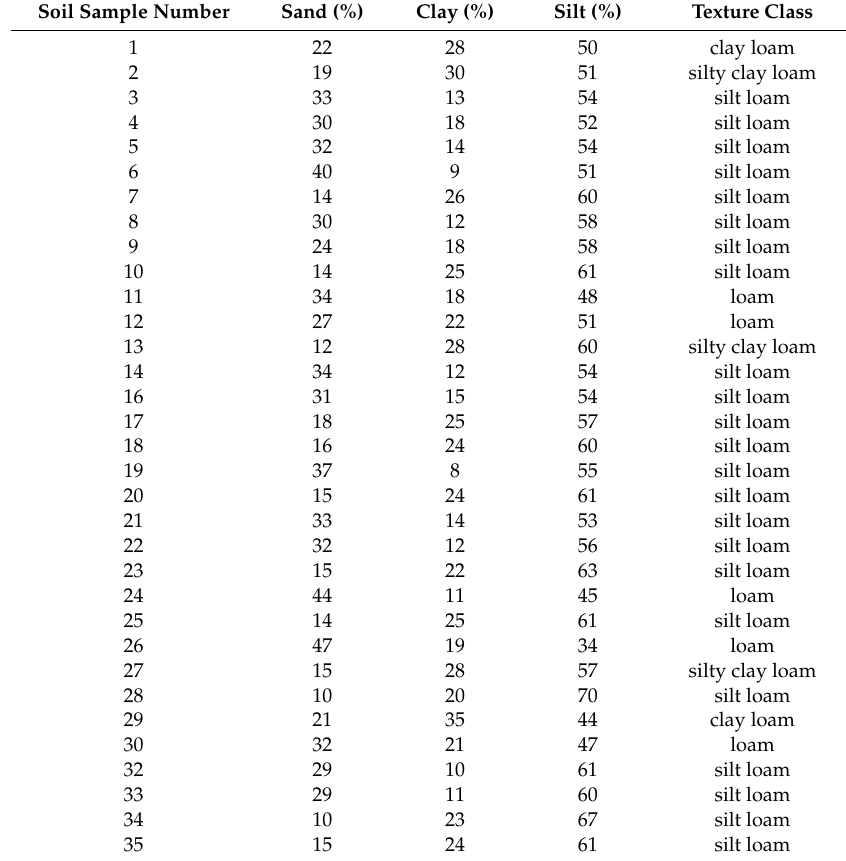
Table A2. On farm soil texture (soil sample taken near the soil moisture sensor). Soil Sample